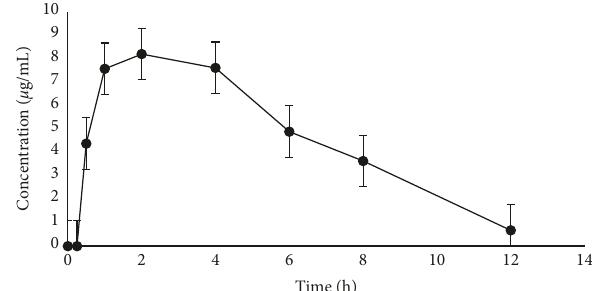
Figure 6: The profile of concentration-time curve after a single dose ( n 8). (cid:31)